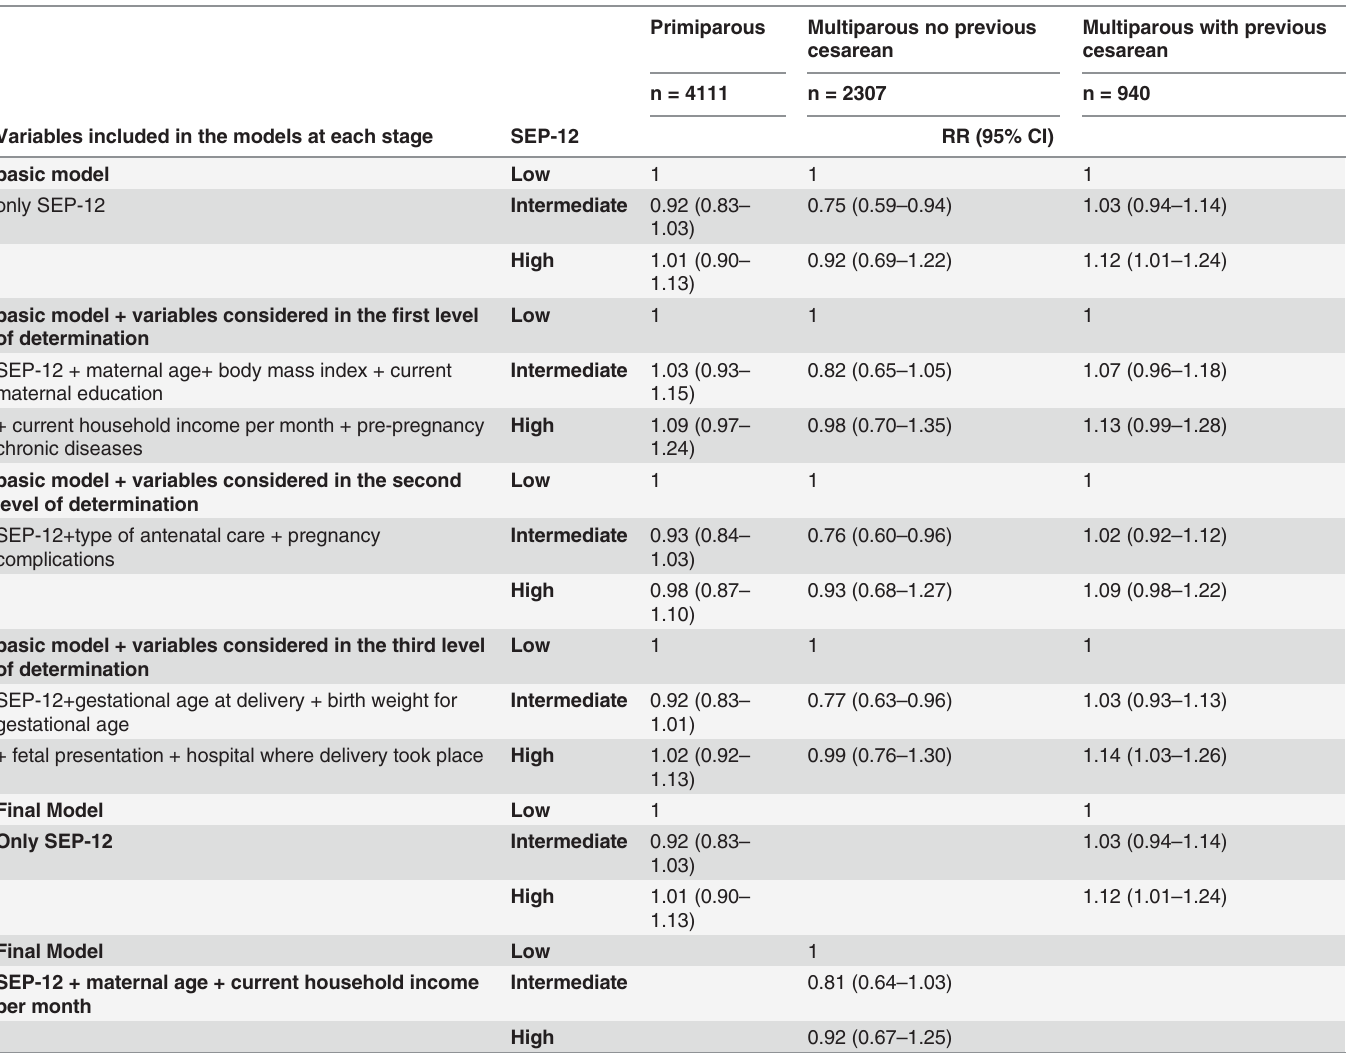
Table 4. Risk ratio for cesarean delivery by